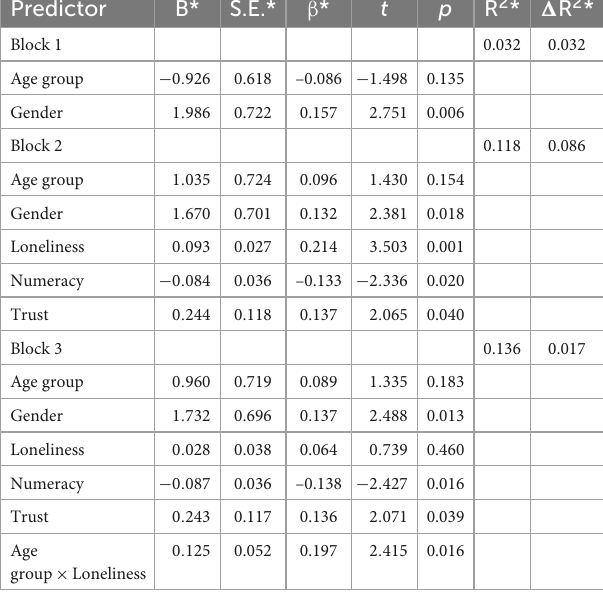
TABLE 2 Final hierarchical regression of age group, loneliness, subjective numeracy, and trust scores on fear of COVID-19.